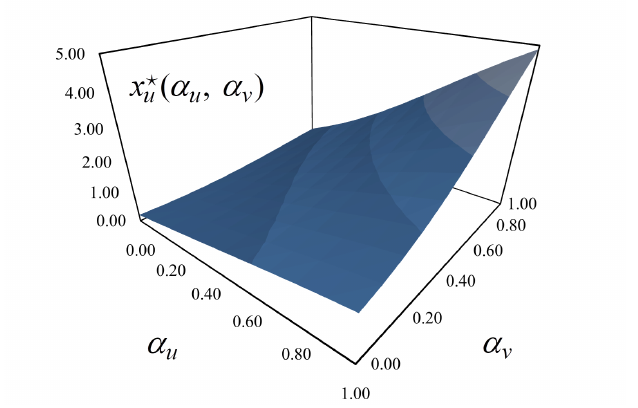
Figure 4. Nash bargaining solution ( x (cid:63) u ) with divergent expectations. The left-sided x -axis corre- sponds to the decay parameter of u ( α u ). The right-sided y -axis is the decay parameter of v ( α v ). The z -axis denotes Nash allocations ( x (cid:63) u ( α u , α v )